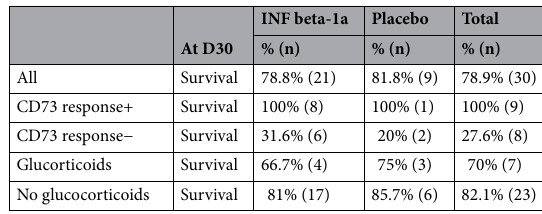
Table 2. Primary outcome for the patients with INF beta 1a treatment vs. placebo, CD73 responders vs. non- responders and postoperative glucococorticoid treatment vs. no